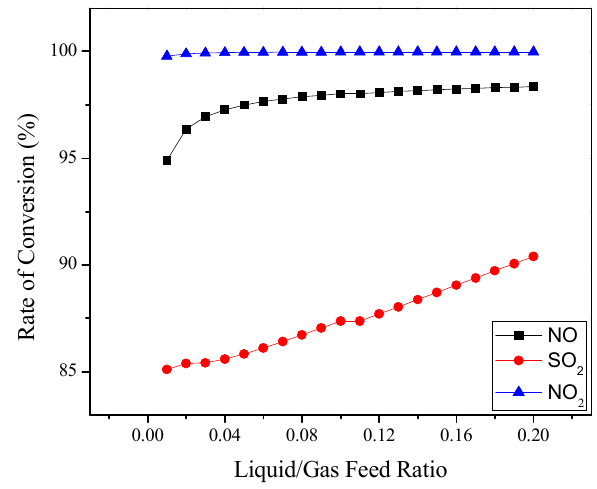
Figure 8. E ff ect of liquid / gas feed ratio on rate of conversion Figure 8. Effect of liquid / gas feed ratio on rate of conversion (%). Figure 8. Effect of liquid / gas feed ratio on rate of conversion (%).